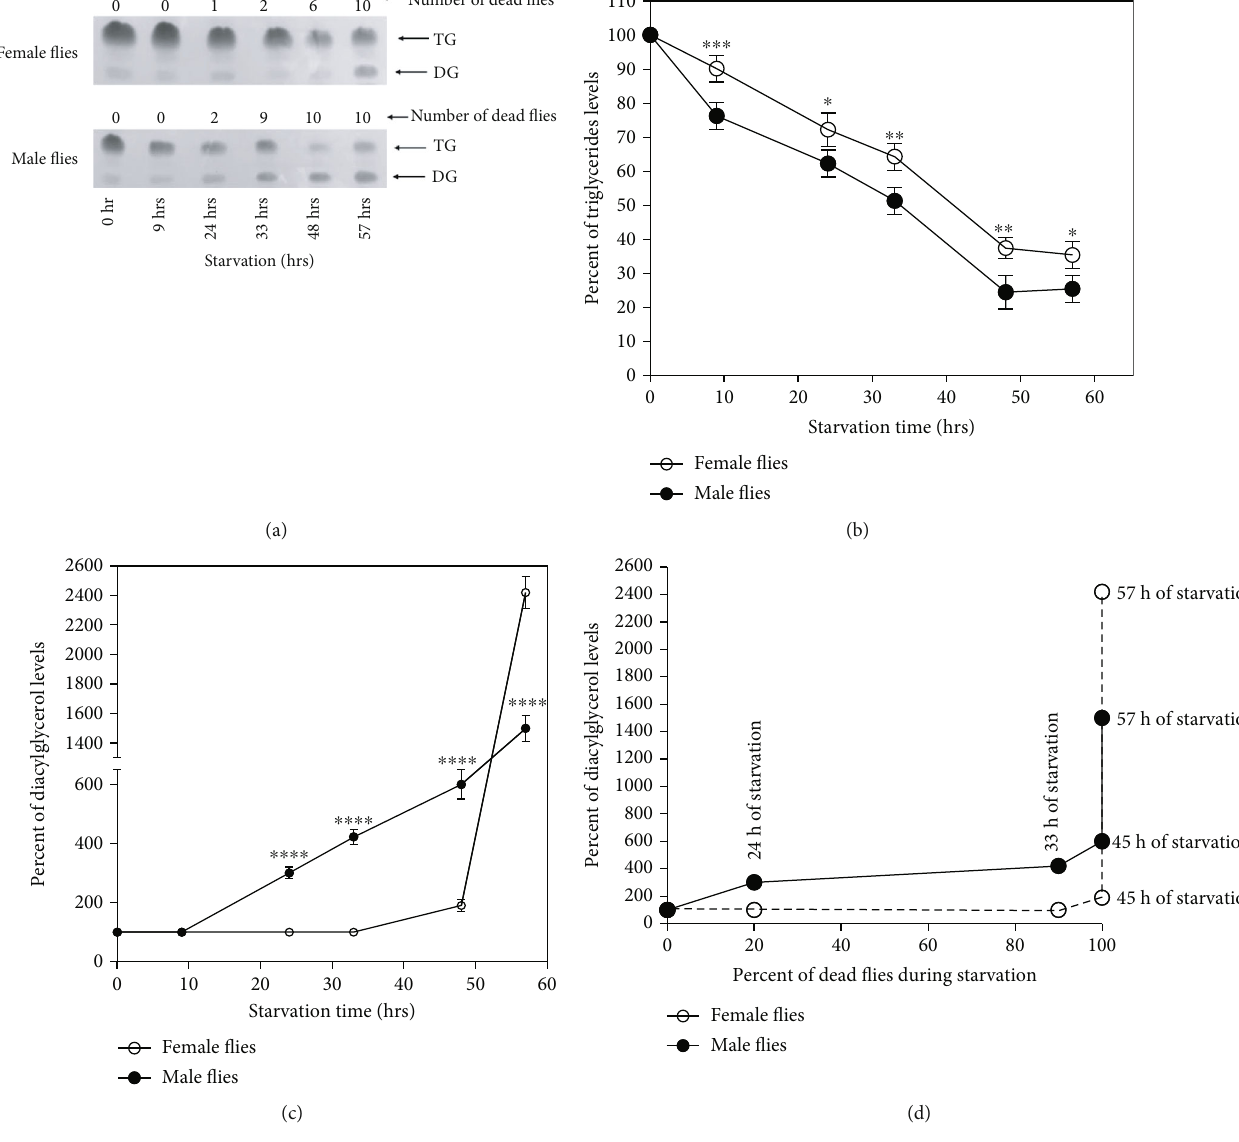
Figure 2: Levels of TG and DG in 2d old male and female fl ies during starvation. Lipids were separated on thin layer chromatography at di ff erent time periods after the male and female fl ies were subjected to starvation (a). The density of the TG spots (b) and DG spots (c) (percent of control) as a function of starvation time was measured. Levels of TG in both male and female fl ies decreased depending upon the duration of starvation. There was a signi fi cant increase in levels of DG in fi nal phase of starvation (48-57h) in female fl ies (c). In male fl ies, DG levels continued to increase after death from 48 to 57h (all 10 male fl ies were dead at 48h of starvation) (c). The percent of DG levels vs. percent of dead male and female fl ies at di ff erent starvation period is shown in (d). The data is representative of three experiments and is presented as the mean ± SD . It was analyzed by two-way ANOVA with Sidak ’ s multiple comparison test. ∗∗∗∗ denotes p < 0 : 0001 , ∗∗∗ denotes p < 0 : 001 , ∗∗ denotes p < 0 : 01 , and ∗ denotes p < 0 : 05